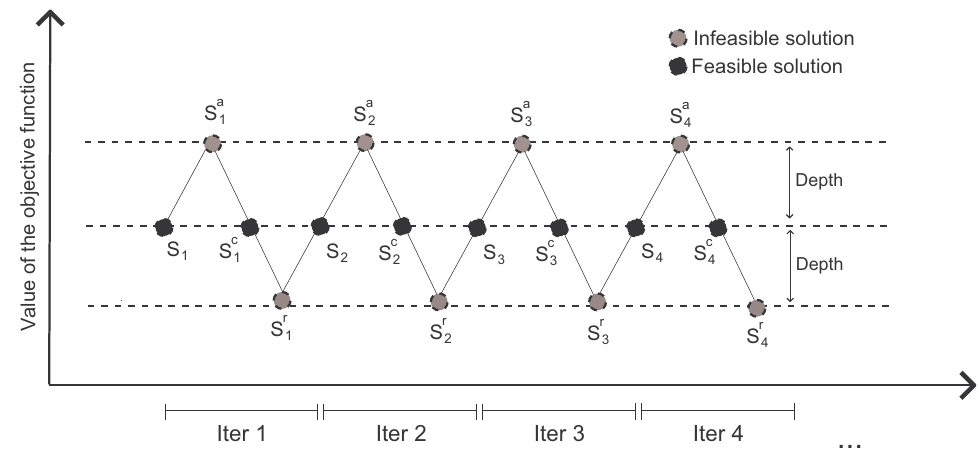
Figure 2. Strategic Oscillation